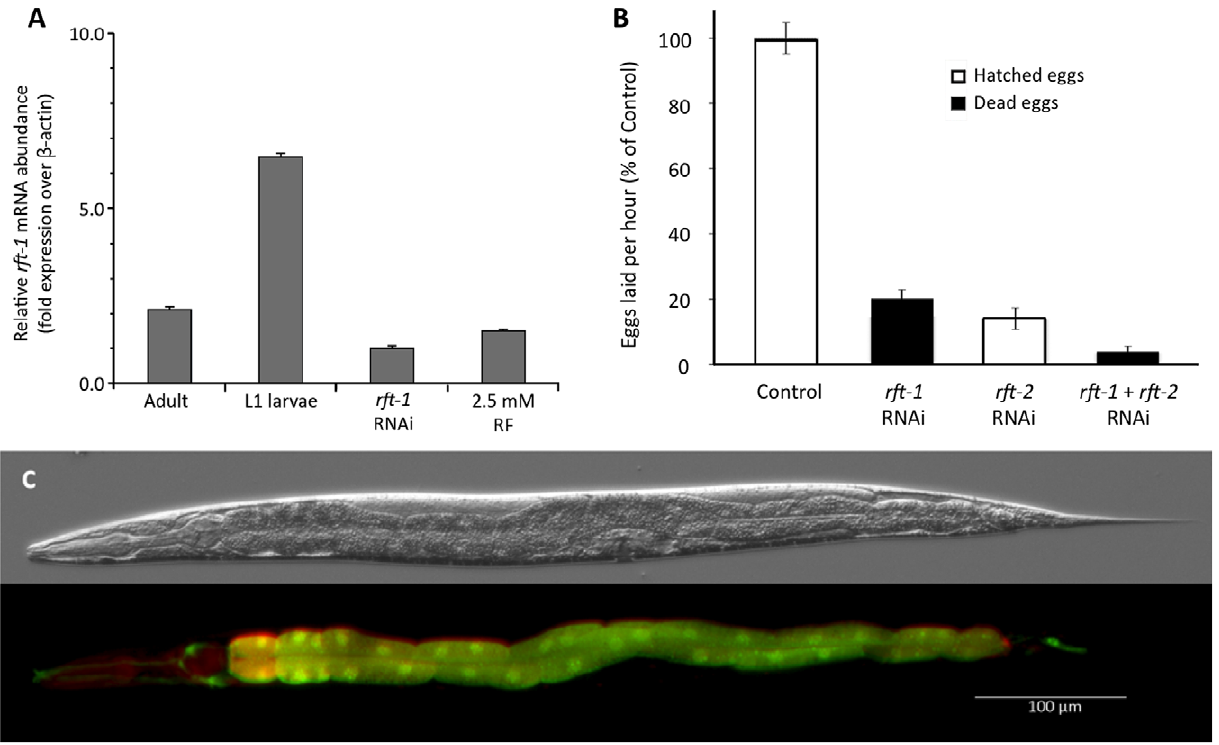
Figure 4. Expression and phenotypes of the riboflavin transporters. (A) Quantitative RT-PCR analysis of rft-1 expression. The data were normalized relative to the housekeeping gene b -actin ( act-2) . All worms were raised on HT115(DE3) bacteria harboring either the rft-1 RNAi feeding plasmid ( rft-1 RNAi worms) or the empty vector, pPD129.36 (all other worms). Additionally, some worms were raised on plates supplemented with riboflavin. (B) The effects of RNAi on egg laying. Here, worms were reared on bacteria harboring the RNAi empty vector (Controls), the rft-1 RNAi feeding vector, the rft-2 RNAi feeding vector, or both RNAi feeding vectors. (C) Micrographs of a worm expressing the transcriptional reporters P rft- 1::gfp and P rft-2::mCherry . Both reporters were expressed in the intestine, whereas only mCherry was found in the pharynx, and only GFP was found in neuronal support cells that spanned the length of the body.